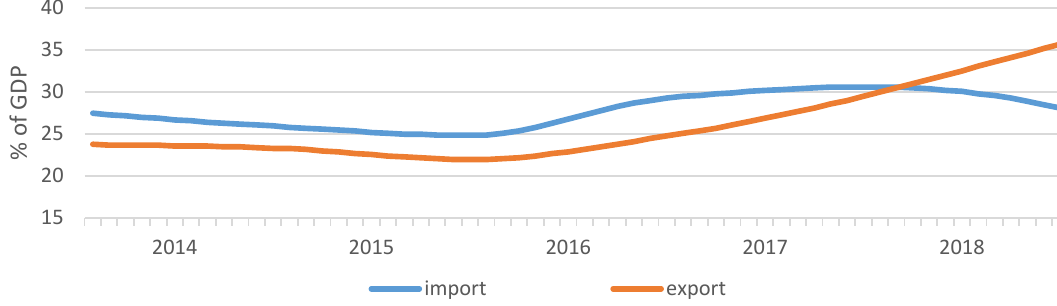
Figure 3. Comparison of the input variables (imports/export % of GDP) trend for predicting electricity demand.